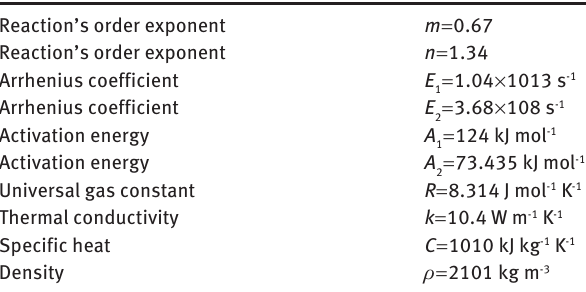
Table 1 Properties and parameters used for simulations [10, 18, 23–25].